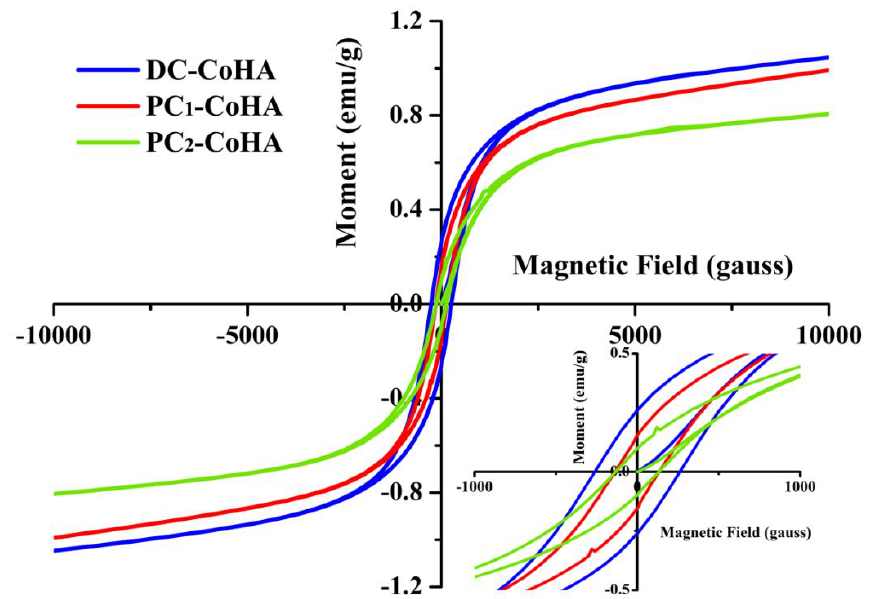
Figure 5. Mass magnetization measurements of Co-HA sample by superconducting quantum interference device (SQUID). device